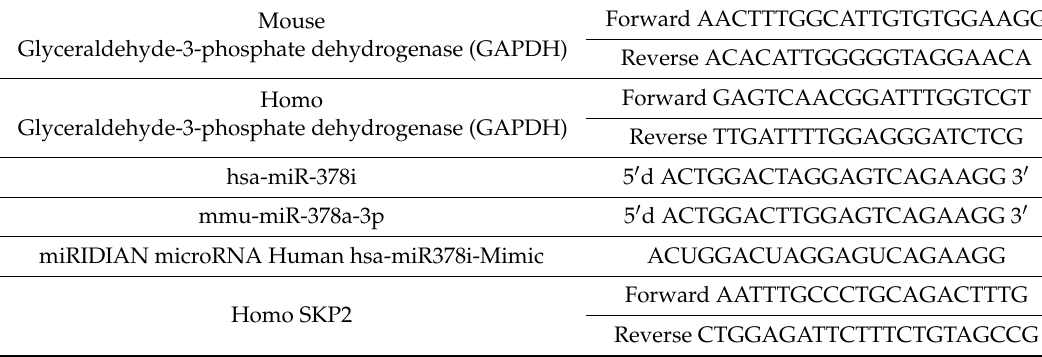
Table 1. Target sequence of materials utilized in the